Question: In a single sentence, describe what this figure presents.
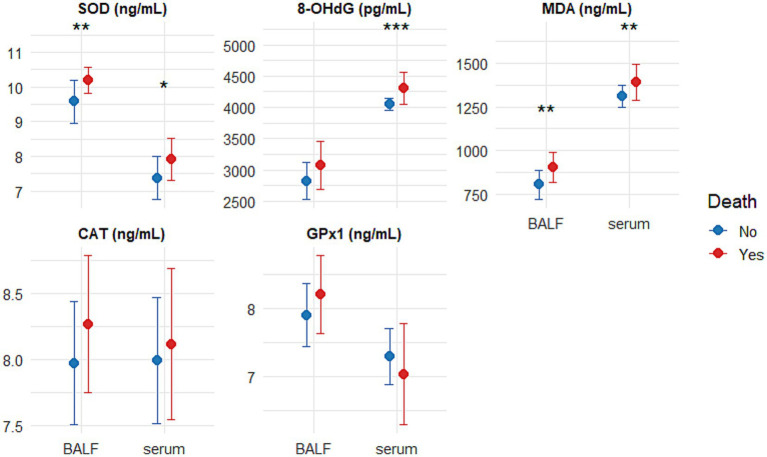
Answer: Serum and BALF (bronchoalveolar lavage fluid) concentrations of selected oxidative stress markers in surviving and non-surviving patients. Non-survivors exhibited significantly higher mean superoxide dismutases (SOD) levels in both BALF ( p = 0.007) and serum ( p = 0.032), higher malondialdehyde MDA levels in both compartments (BALF: p = 0.004; serum: p = 0.009), and higher serum hydroxydeoxyguanosine (8-OHdG,) concentrations ( p < 0.001). No significant differences were observed for catalase (CAT) or glutathione peroxidase (GPx) in either compartment. The difference in BALF 8-OHdG between groups did not reach statistical significance ( p = 0.056).